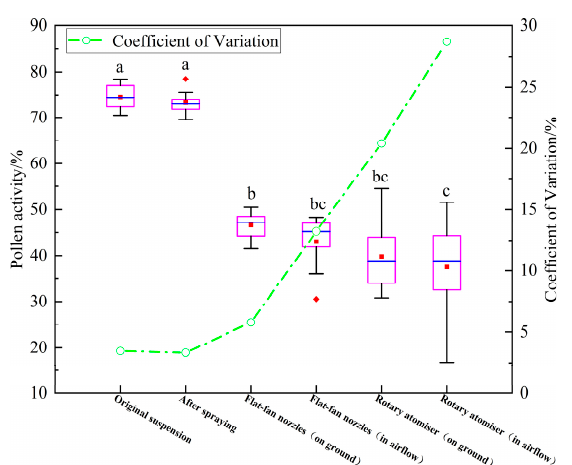
Figure 6. Results of the influence of the downwash airflow field of the UAVS on the pollen activity. The pollen suspension after the spraying was completed was used as the control group. Additionally, the pollen activity in the pollen suspension received when the UAVS was on the ground was compared with the pollen activity in the pollen suspension received in the UAVS downwash airflow field. Different letters indicate significant differences (Duncan test, α = 0.05).